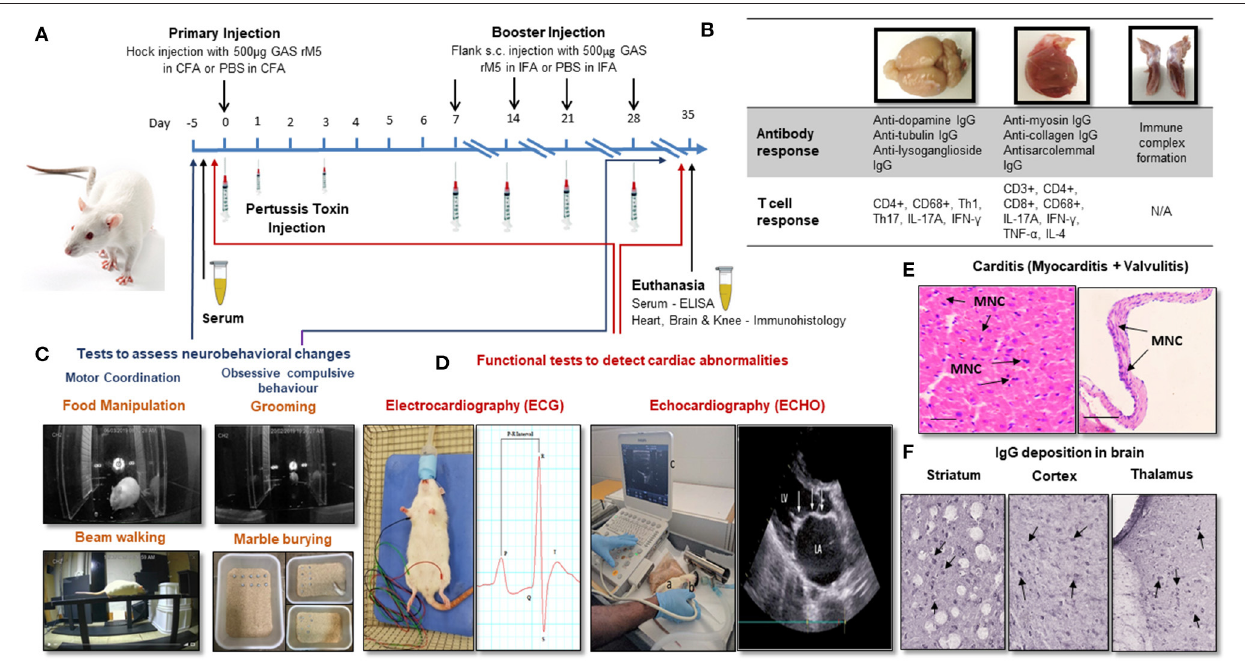
FIGURE 1 | Procedures for the induction of carditis and neurobehavioral changes in Lewis rats. (A) Carditis, valvulitis and neurobehavioral changes can be induced by injection of Lewis rats with GAS antigens followed by Bordetella pertussis toxin injection and booster injection of GAS antigens. (B) Antibody and T cell response can be assessed in brain, heart and knee joints following injection of GAS antigens. (C) Standard behavioral tests to assess neurobehavioral changes following exposure to GAS antigens. (D) ECG and ECHO changes will demonstrate impairment cardiac function. (E) Characteristic mononuclear cell infiltration in the myocardium and valvular tissue (arrows) can be demonstrated in the histological sections of cardiac tissue from rats injected with GAS antigens. (F) IgG deposition can be demonstrated in sections of brain following incubation with sera from rats exposed to GAS antigens. CFA, Complete Freund’s Adjuvant; IFA, Complete Freund’s Adjuvant; PBS, Phosphate Buffered Saline; GAS rM5, Recombinant M5 protein of Group A streptococcus; ELISA, Enzyme Linked Immunosorbent Assay; Th, Helper T-cell; TNF, Tumor Necrosis Factor; IFN, Interferon; IgG, immunoglobulin G; IL, interleukin; MNC, Mononuclear Cell.